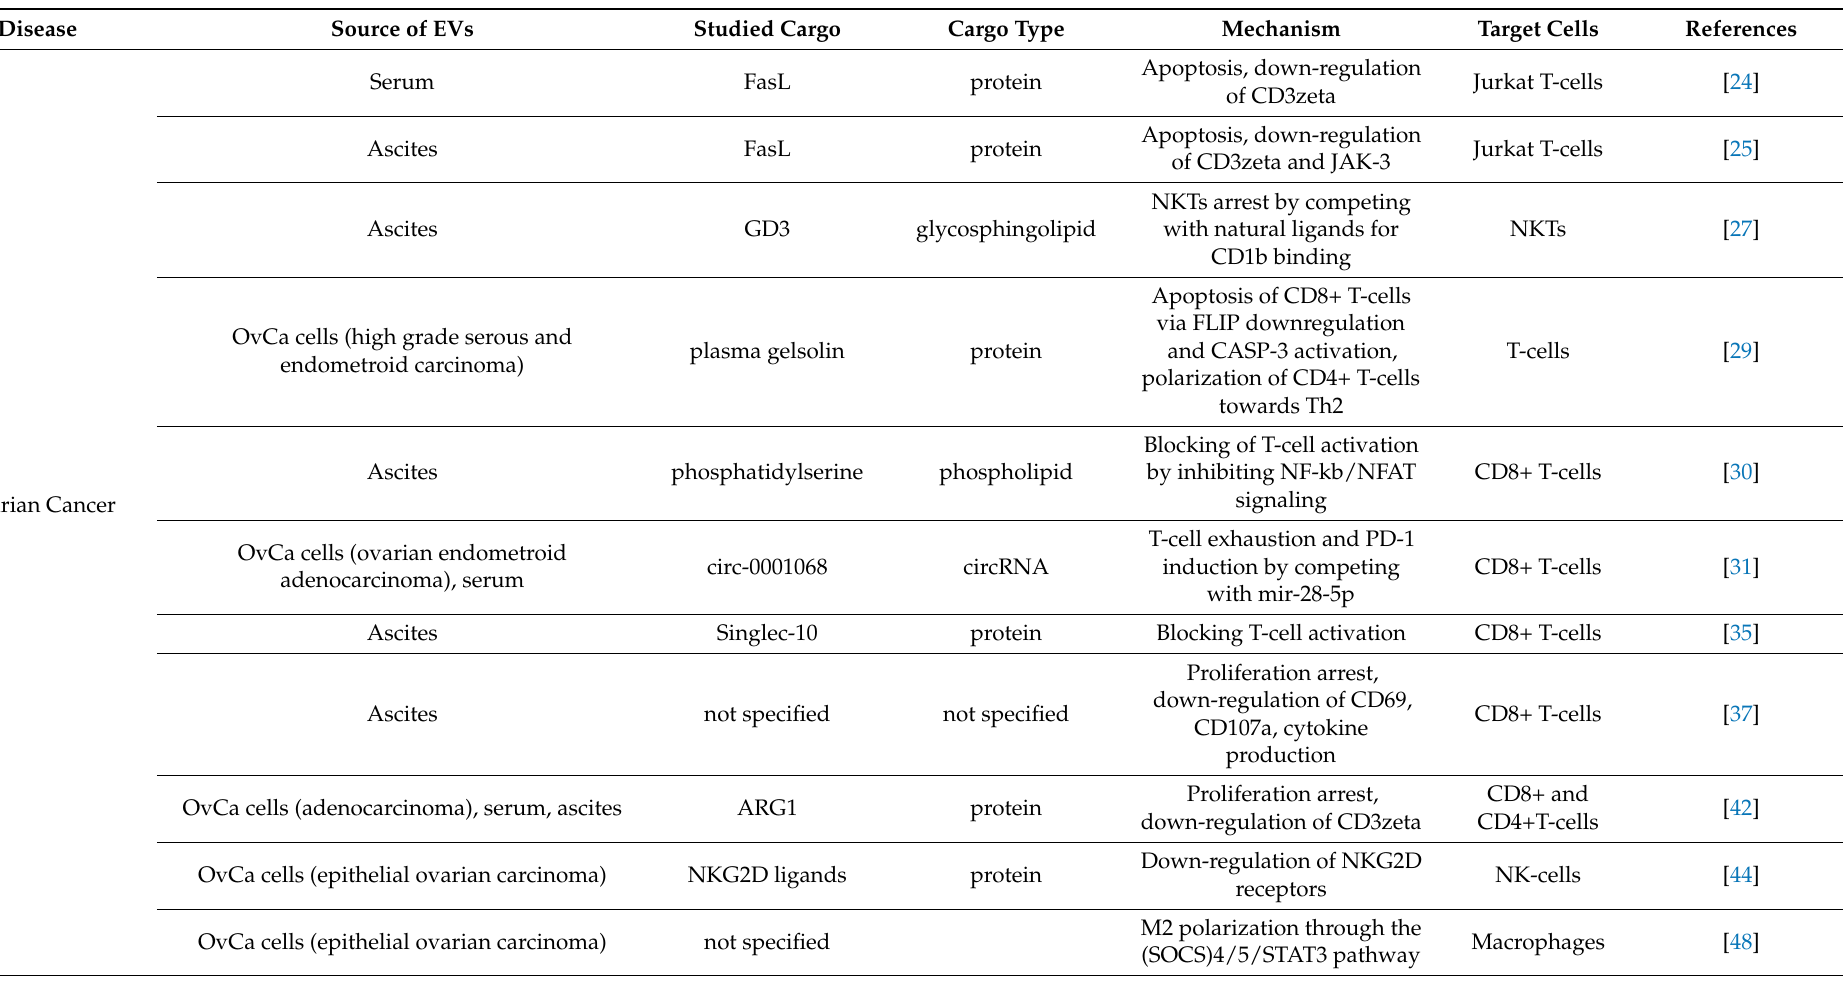
Table 1. A detailed summary of EV-mediated immunosuppressive mechanisms in ovarian cancer, endometrial cancer and